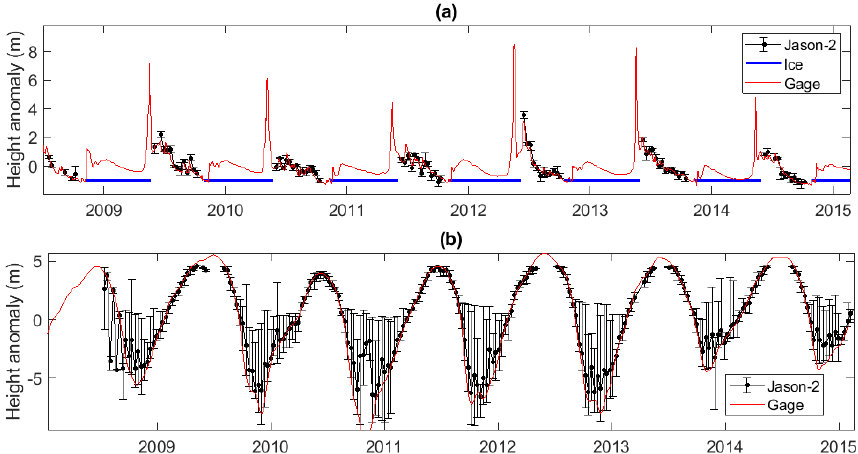
Figure 2. Example time series for the Mackenzie River. Panel (a) shows water surface heights with ice filtering compared to the Environment Canada gage (10KA001) located 684km away from the virtual station. Panel (b) compares the time series derived from Jason-2 for one of the Amazon gages. Error bars represent the range of the values that were averaged to generate each data point (does not include filtered data points).